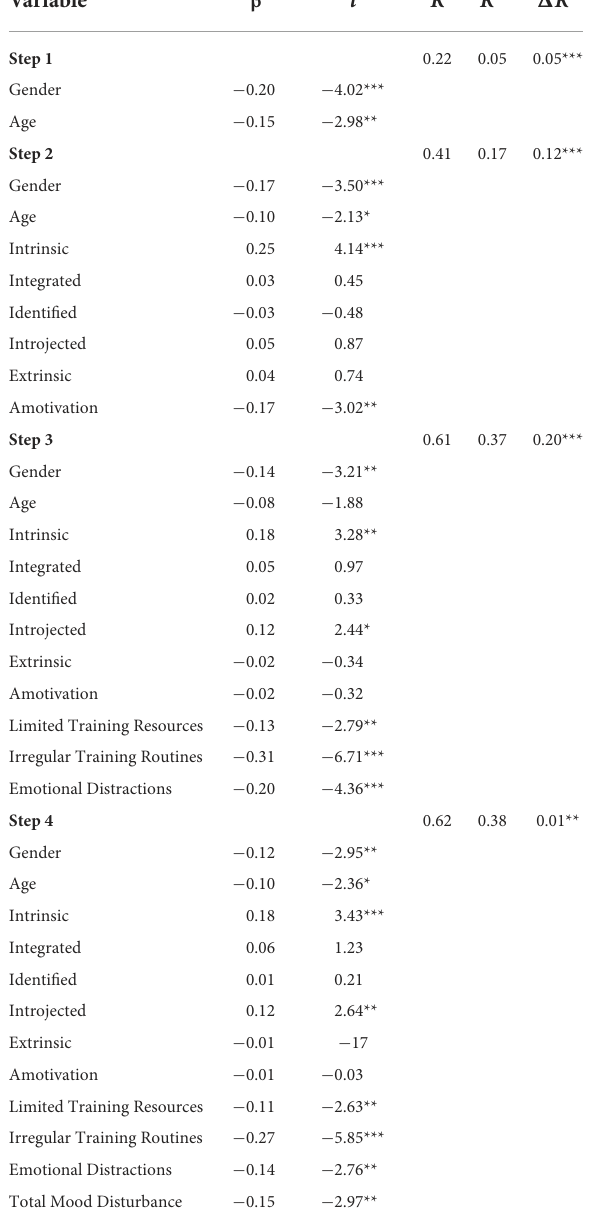
TABLE 5 Hierarchical multiple regression for predicting motivation to